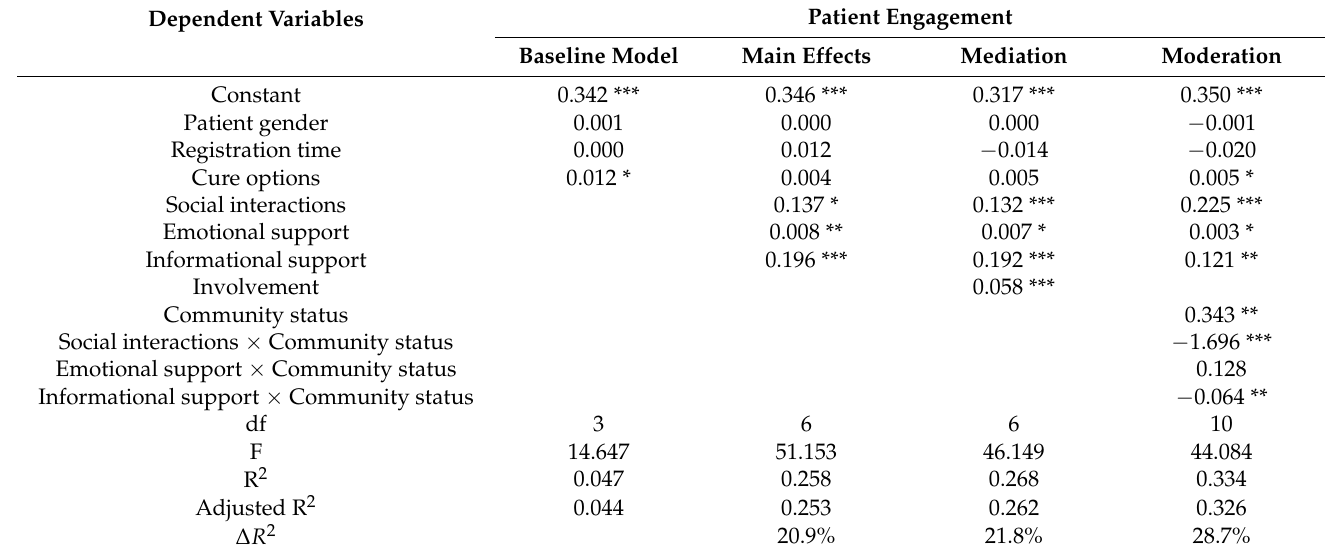
Table 8. Results of different